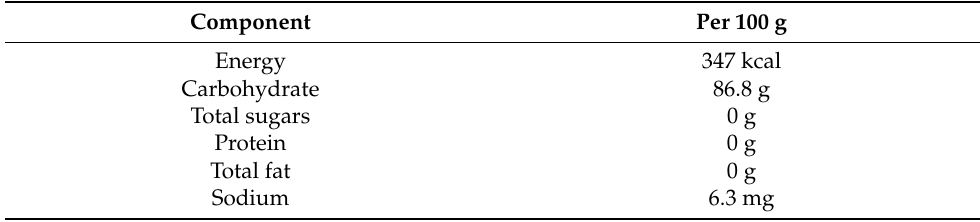
Table 1. Information of sago starch.